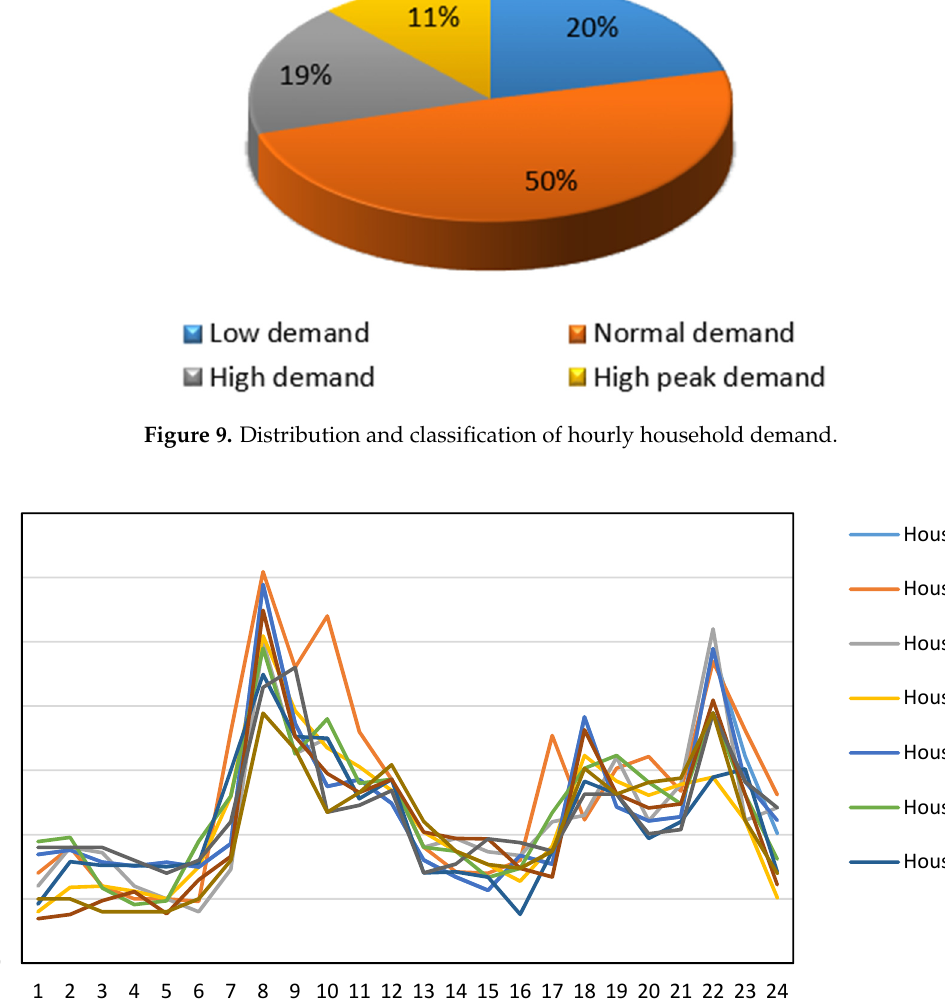
12 of 32 Table 4. Overall statistical data analysis forhousehold demand.